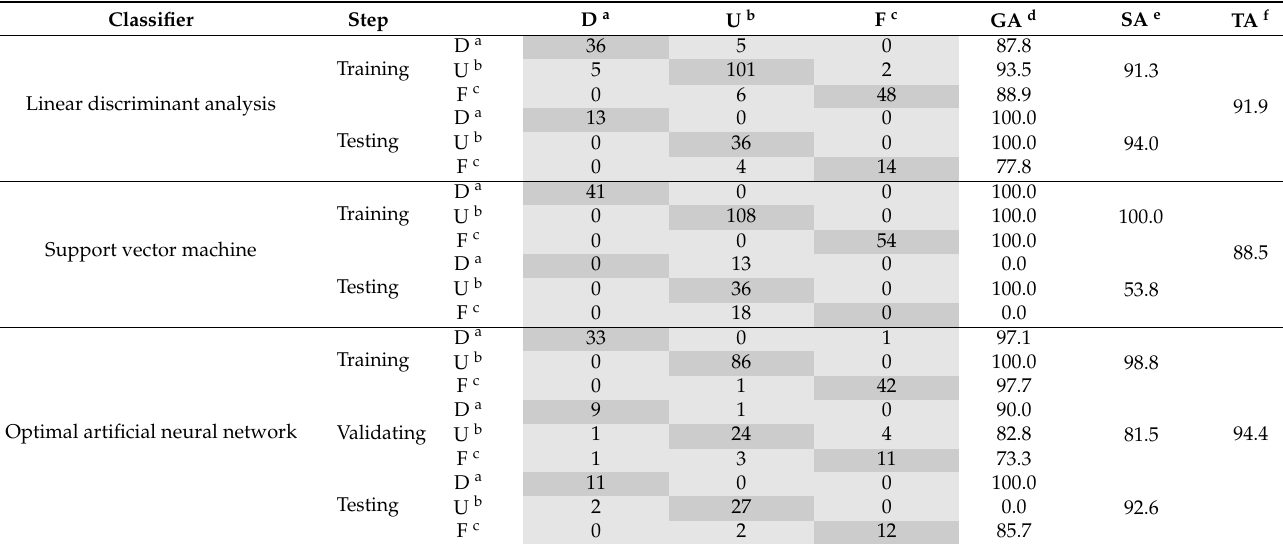
Table 2. Confusion matrices associated with different